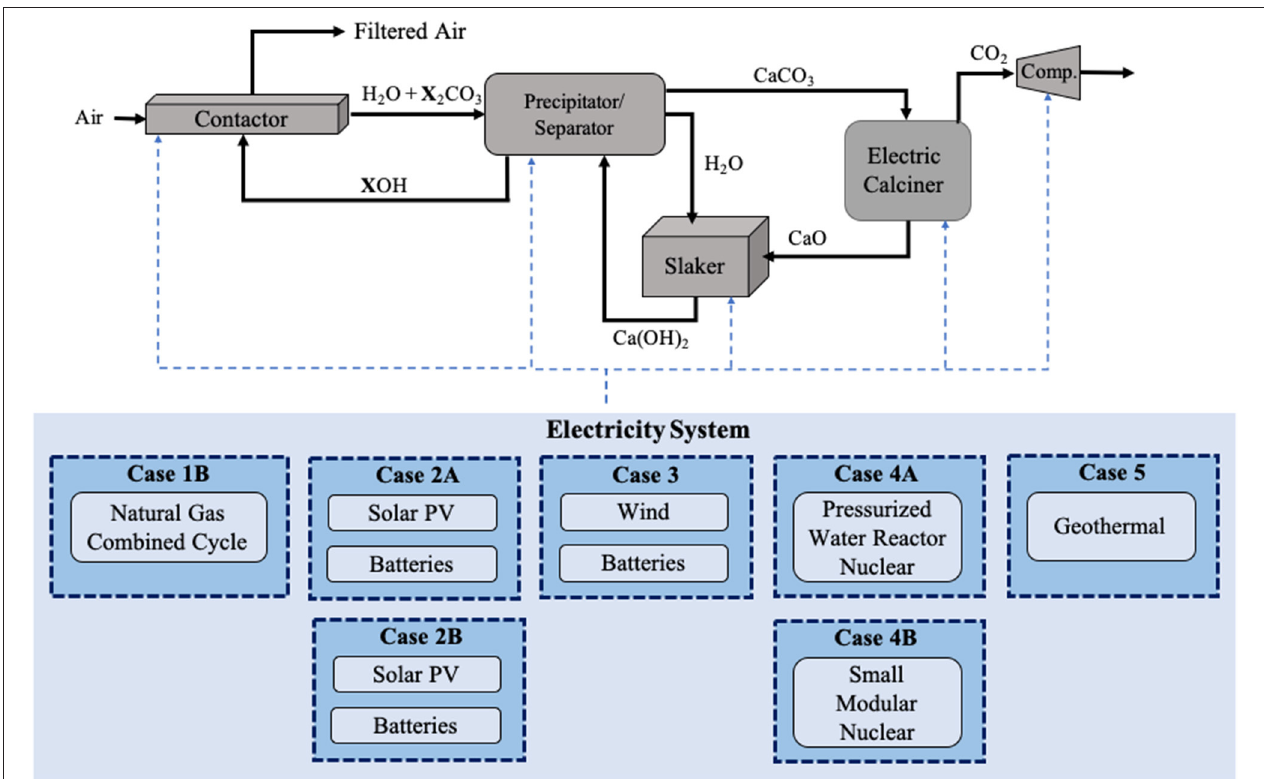
FIGURE 3 | Schematic of DAC Case 1B through Case 5 where all energy requirements for the system are met using electricity through the use of an electric kiln. The dashed blue arrows represent the flow of electricity within the system. Here, X represented sodium (Na) or potassium (K) depending on the hydroxide used.